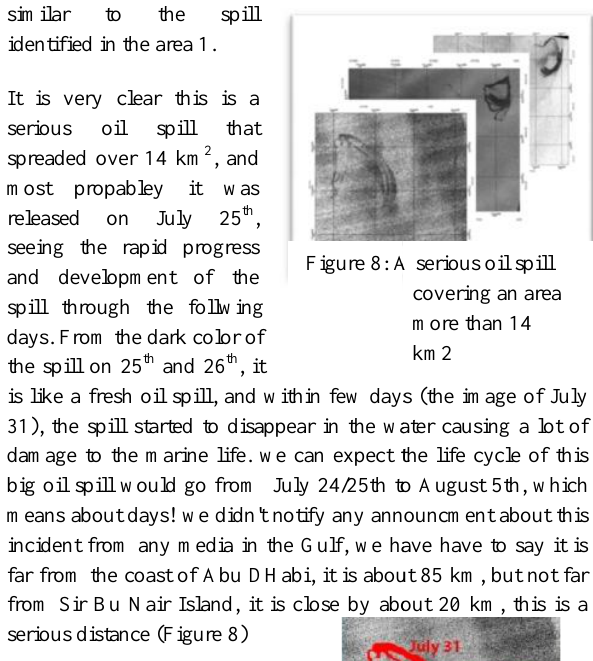
Figure 8: A serious oil spill